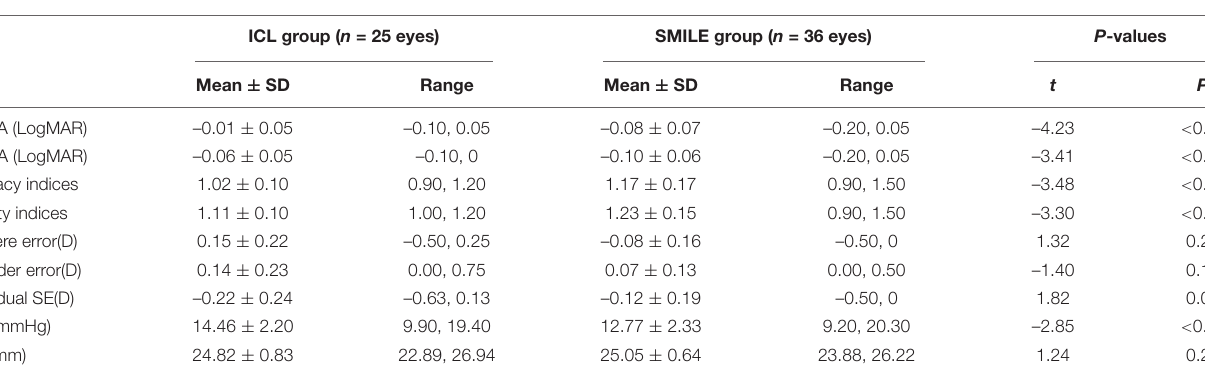
TABLE 2 | Postoperative parameters of the two